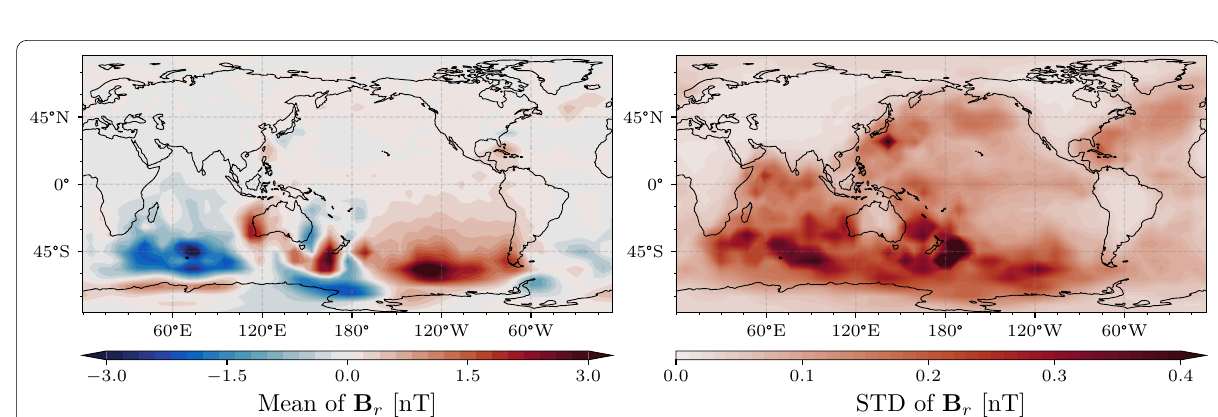
Fig. 2 Mean (left) and standard deviation (right) of the radial component of the magnetic field from ocean circulation (calculated from ECCO2 data) at sea surface height. The spatial resolution corresponds to a decomposition to spherical harmonic functions up to degree